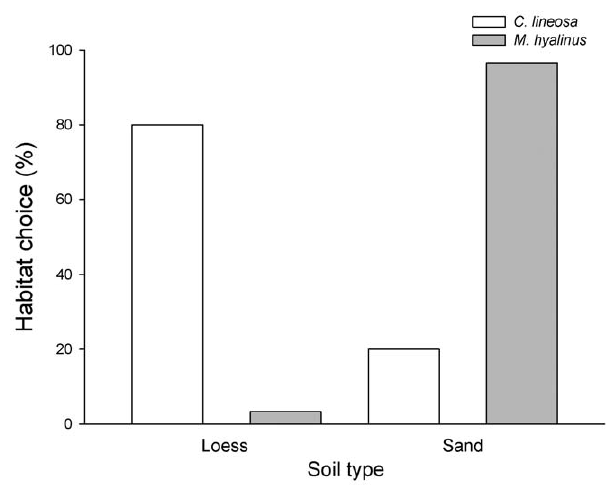
Figure 7. Habitat choice of antlions. Both antlion species discriminate between soils, choosing the soil type providing a higher prey capture success and characterizing their primary habitat-of-origin.